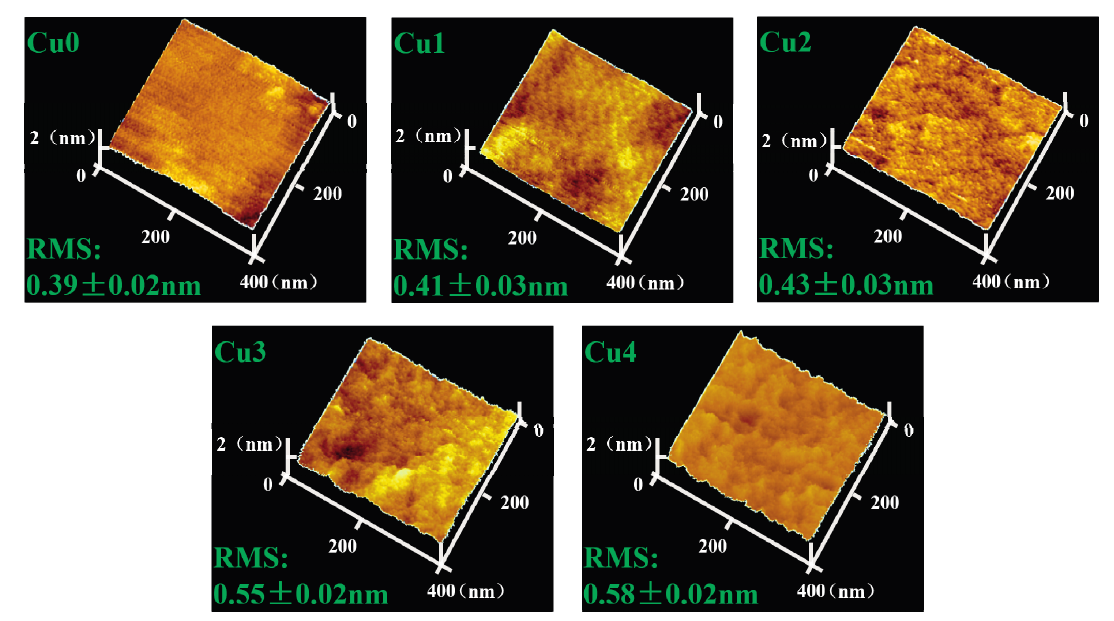
Figure 2. The AFM characterization of the Cu0, Cu1, Cu2, Cu3 and Cu4 samples. The crystalline structures of the Cu doped TiO 2 films (Cu0, Cu1, Cu2, Cu3 and Cu4) detected by XRD are displayed in Figure 3. The major phase was anatase when the films were calcined at 450 °C. Small diffraction peaks of CuO appear at 2 θ = 35.6° on Cu4 samples. No Cu peak was observed on Cu1, Cu2 or Cu3 samples, and it could be attributed to either small amount of Cu loading or very small Cu cluster size. The XRD results indicated that the doped Cu element mainly survived as a state of CuO.